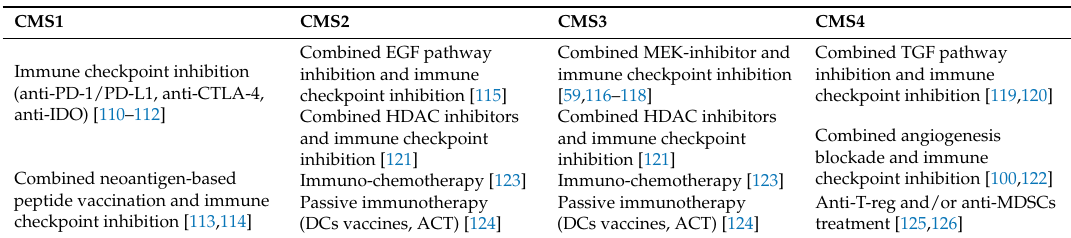
Table 1. Potential strategies for immunotherapy across consensus molecular subtypes (CMS) of colorectal cancer